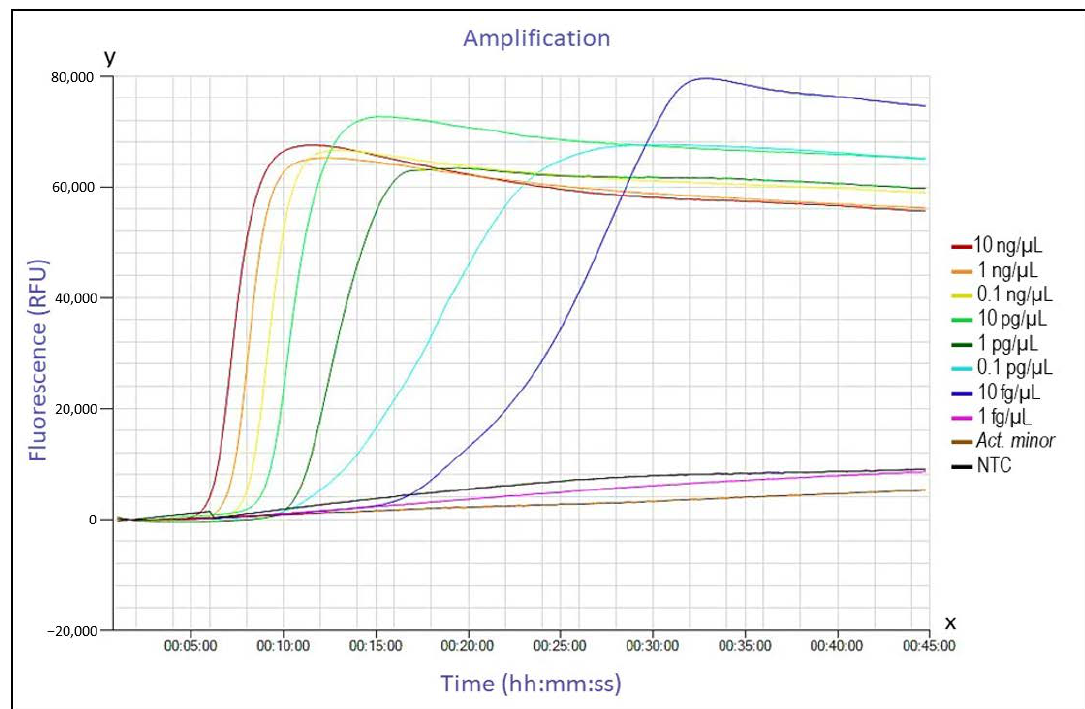
Figure 2. Example of a typical LAMP run in Genie ® II. The graph was created in the program Genie Explorer and shows an analytical sensitivity test using the concentrated master mix. The x-axis shows the amplification time (hh:mm:ss), while the y-axis shows the fluorescence expressed in relative fluorescence units (RFU). Red, orange, yellow, green, dark green, blue, dark blue, and pink are the colors used to represent ten-fold serial dilutions of G. ( H.) parasuis (DSM 21448) genomic DNA from 10 ng/µL to 1 fg/µL, respectively. The brown curve represents DNA from Actinobacillus minor strain CCUG 38923 T (0.1 ng/µL) and the black curve represents the no template control (NTC).